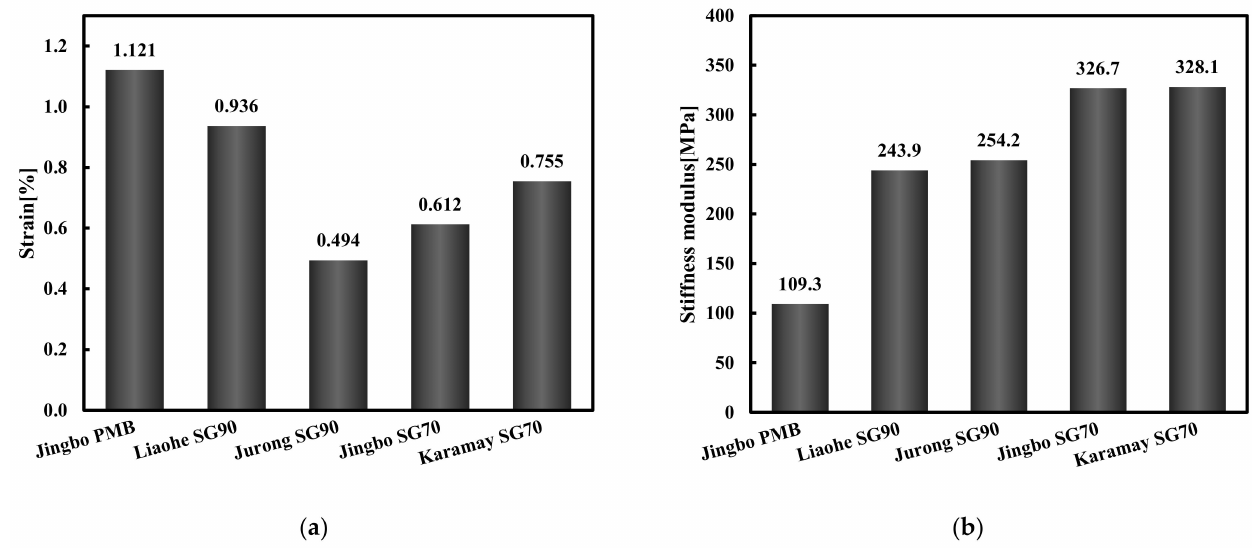
Figure 11. Tensile fracture strain ( a ) and stiffness modulus ( b ) of five hydraulic bitumen binders at − 25 ◦